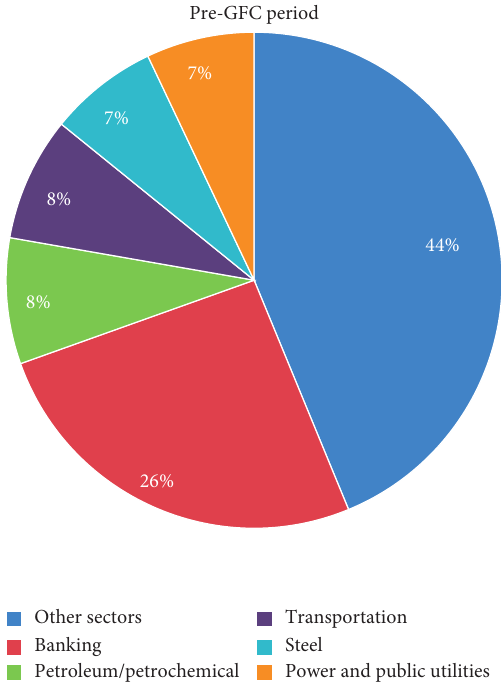
Figure 4: CES in the pre-GFC period (%).